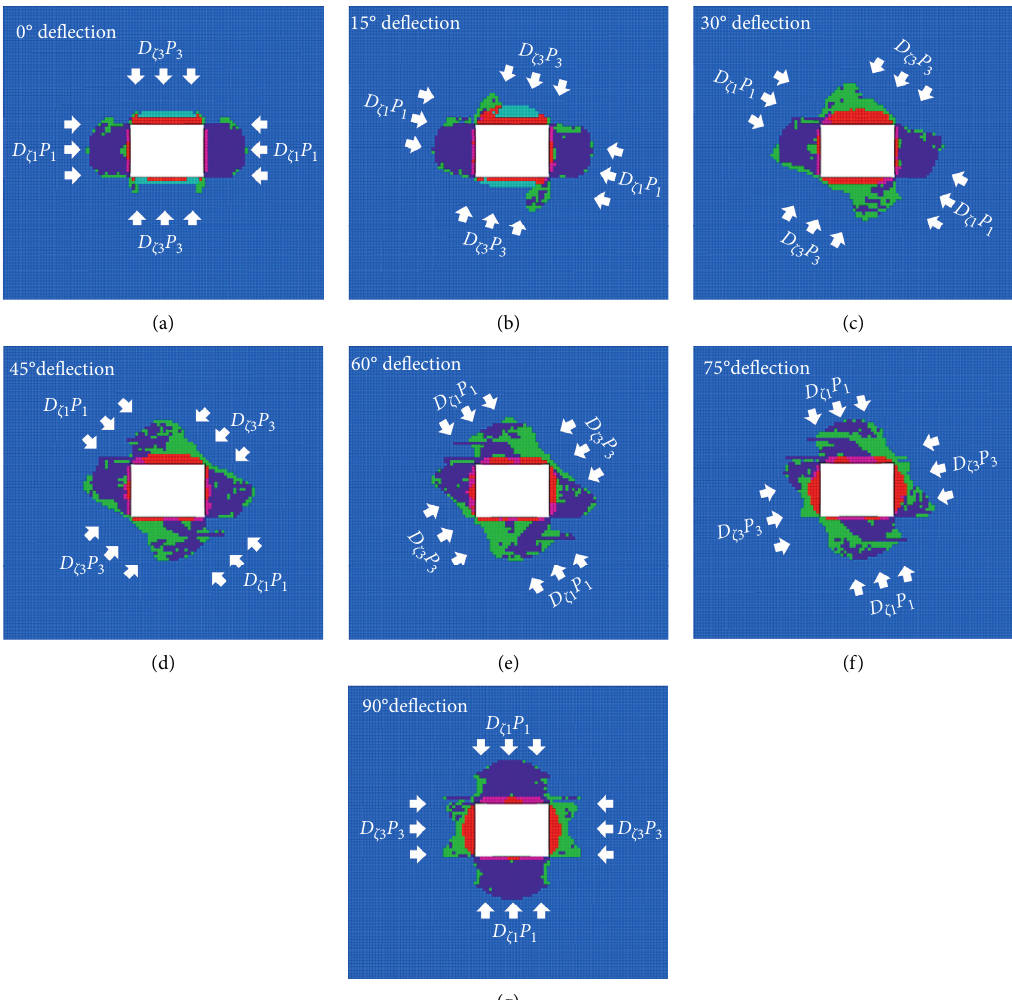
Figure 7: Morphology distribution of the surrounding rock plastic zone in the roadway influenced by stresses with different